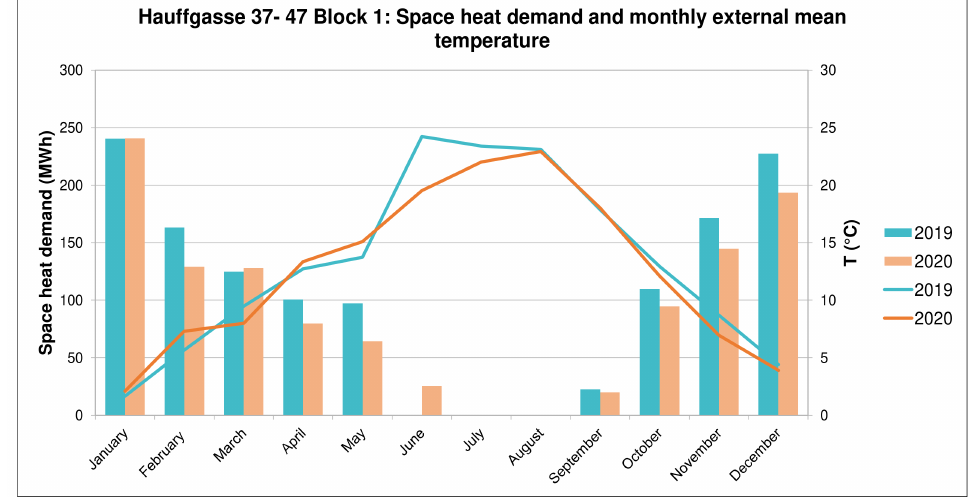
Figure 10. Monthly space-heat demand for 2019 and 2020, Hauffgasse,